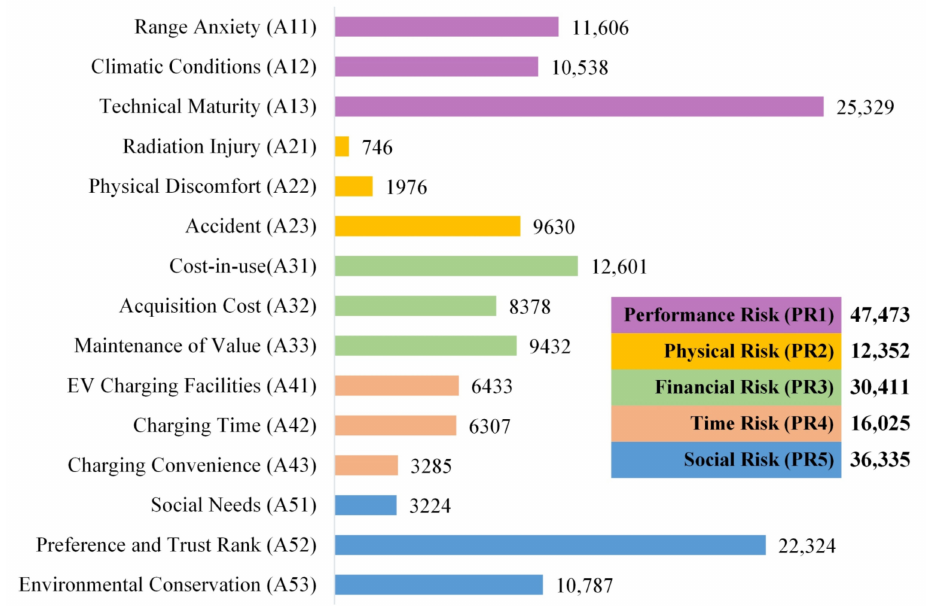
Figure 6. Histogram of Distribution of Customer Perceived Risks about EVs.